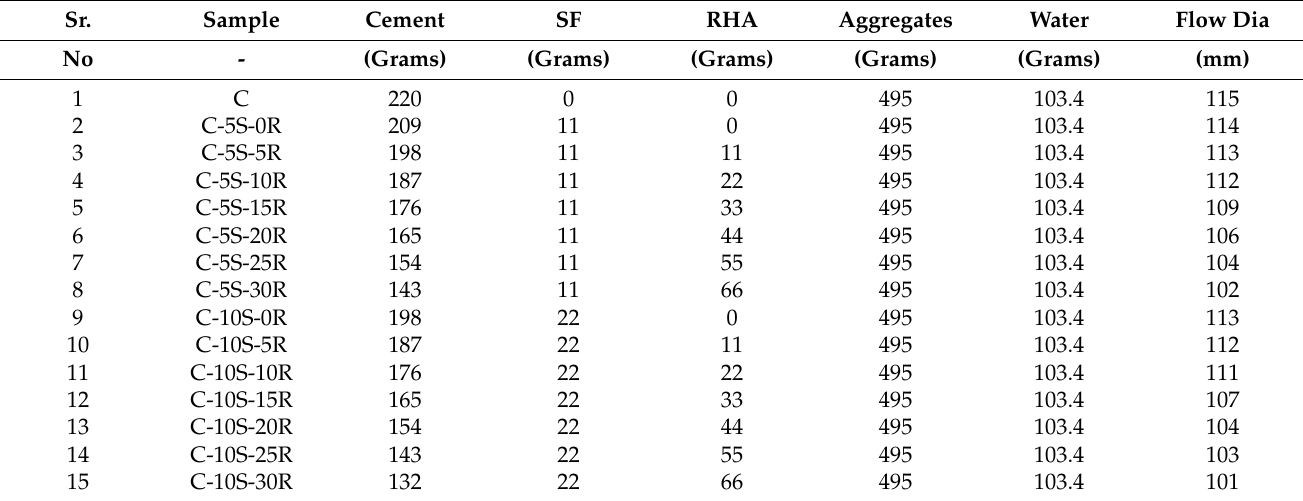
Table 5. Results of Flowability of mortar incorporating SF and RHA.